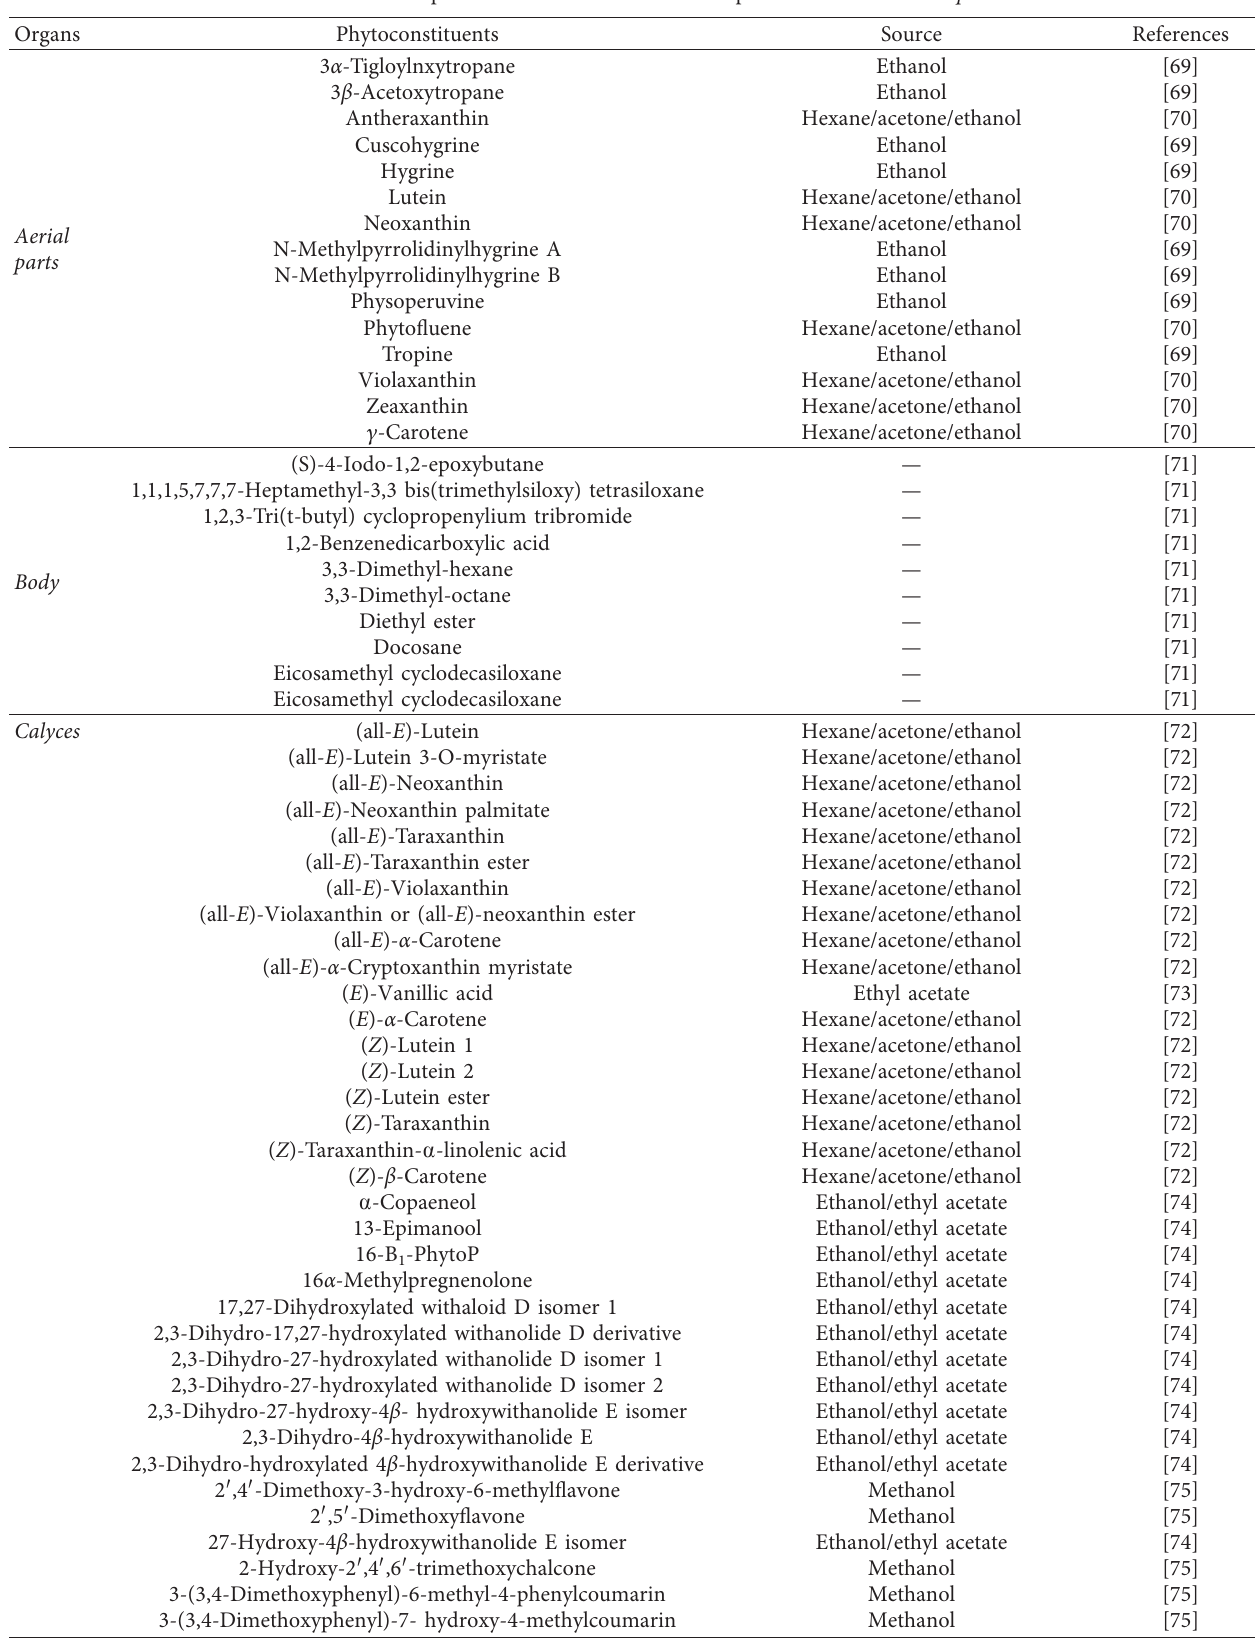
Table 2: Chemical compounds identified from different parts and extracts of P . peruviana .